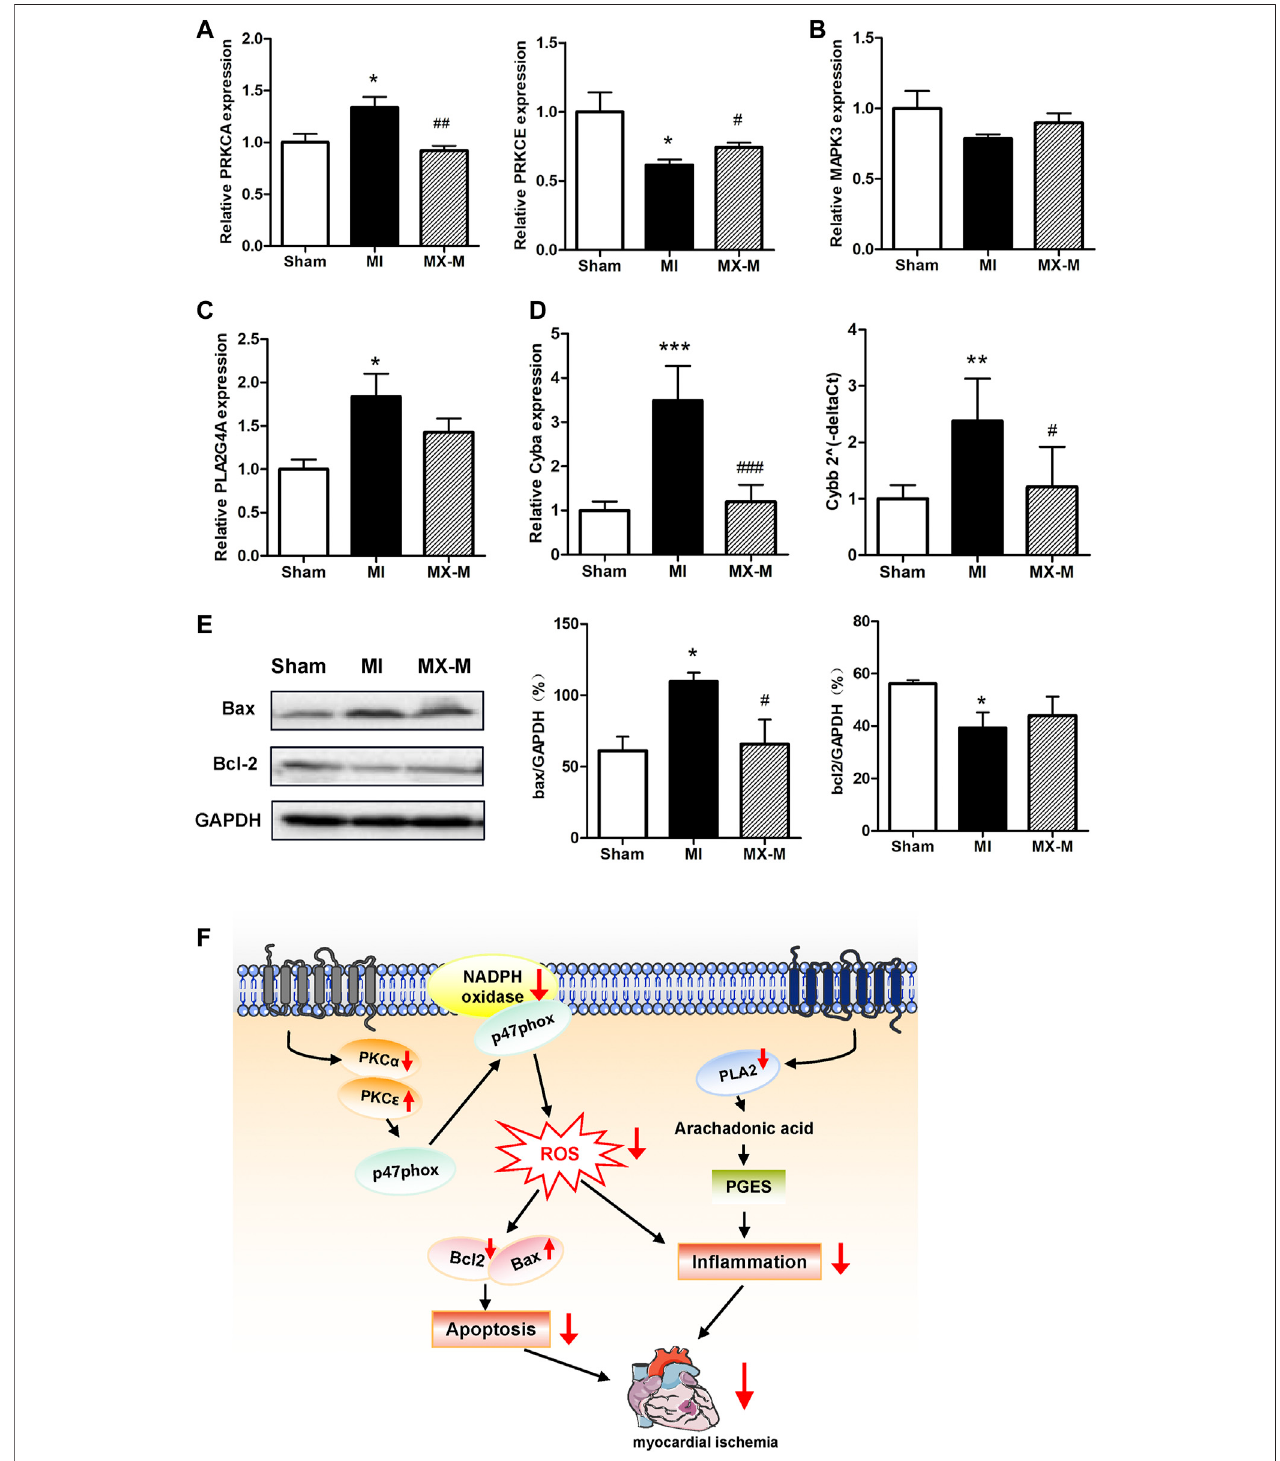
FIGURE5| Mechanismsoftheprotectiveeffects ofXMLinjectiononmyocardial ischemia. (A) RelativePRKCAand PRKCEtranscript levelsintheSham( n =5), MI ( n = 4), and MX-M ( n = 6) groups. (B,C) Relative MAPK3 (B) and PLA2G4A (C) transcript levels in the Sham ( n = 5), MI ( n = 4), and MX-M ( n = 6) groups. (D) CYBA and CYBB genetranscript abundanceintheSham ( n =5), MI( n =4),and MX-M ( n =6)groups. (E) Abundance ofBaxand Bcl-2 proteins intheSham,MI, and MX-M groups ( n = 3). (F) Schematic model for the molecular mechanisms associated with the protective effect of XML injection against myocardial ischemia. Asterisk (*) refers to statistical signi fi cance in comparisons with the CON group (* p < 0.05, ** p < 0.01, *** p < 0.005), while # refers to comparisons with the EPI group ( # p ＜ 0.05, ## p < 0.01, ### p < 0.005).